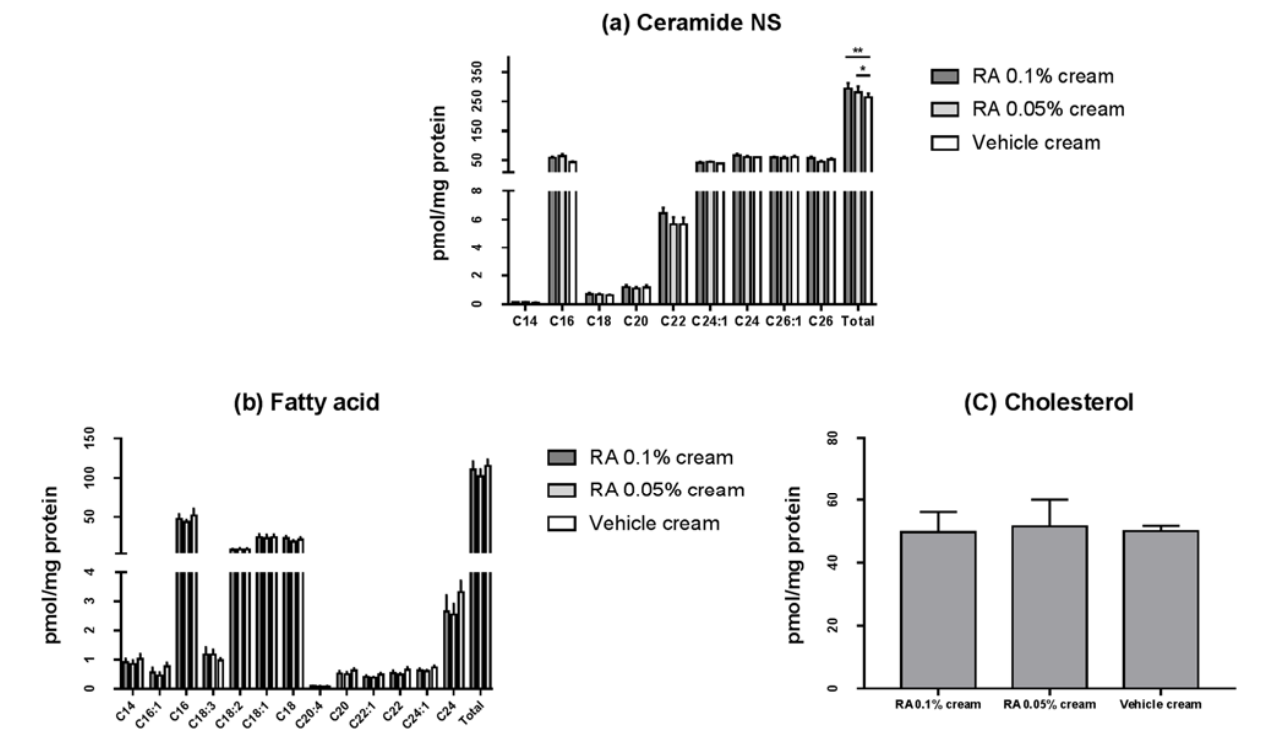
Figure 4. Epidermal lipid analysis in 3D ‐ cultured skin after topical application. Epidermal lipid analysis after the NHE1 activator cream (containing 0.05% or 0.1% rosmarinic acid) or vehicle cream application. ( a ) Ceramide NS, ( b ) fatty acid, and ( c ) cholesterol. Data are presented as the mean ± SD ( n = 3). RA, rosmarinic acid. Unpaired Student’s t ‐ test p ‐ values indicate statistical significance (* p < 0.05, and ** p < 0.01).